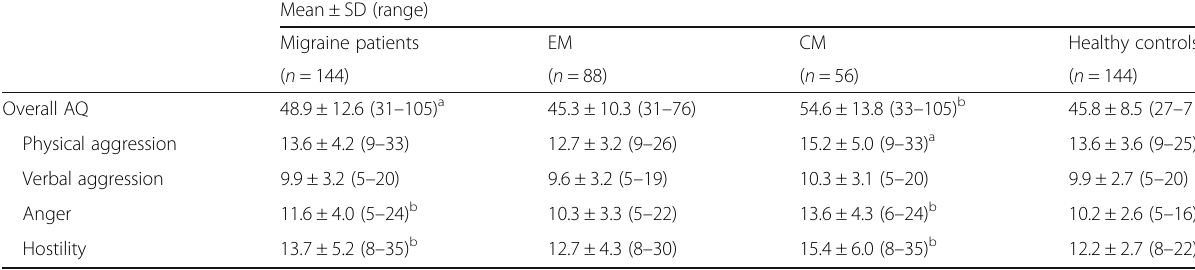
Table 2 Aggression in migraine patients compared with healthy controls Mean ± SD (range) Migraine patients EM CM Healthy